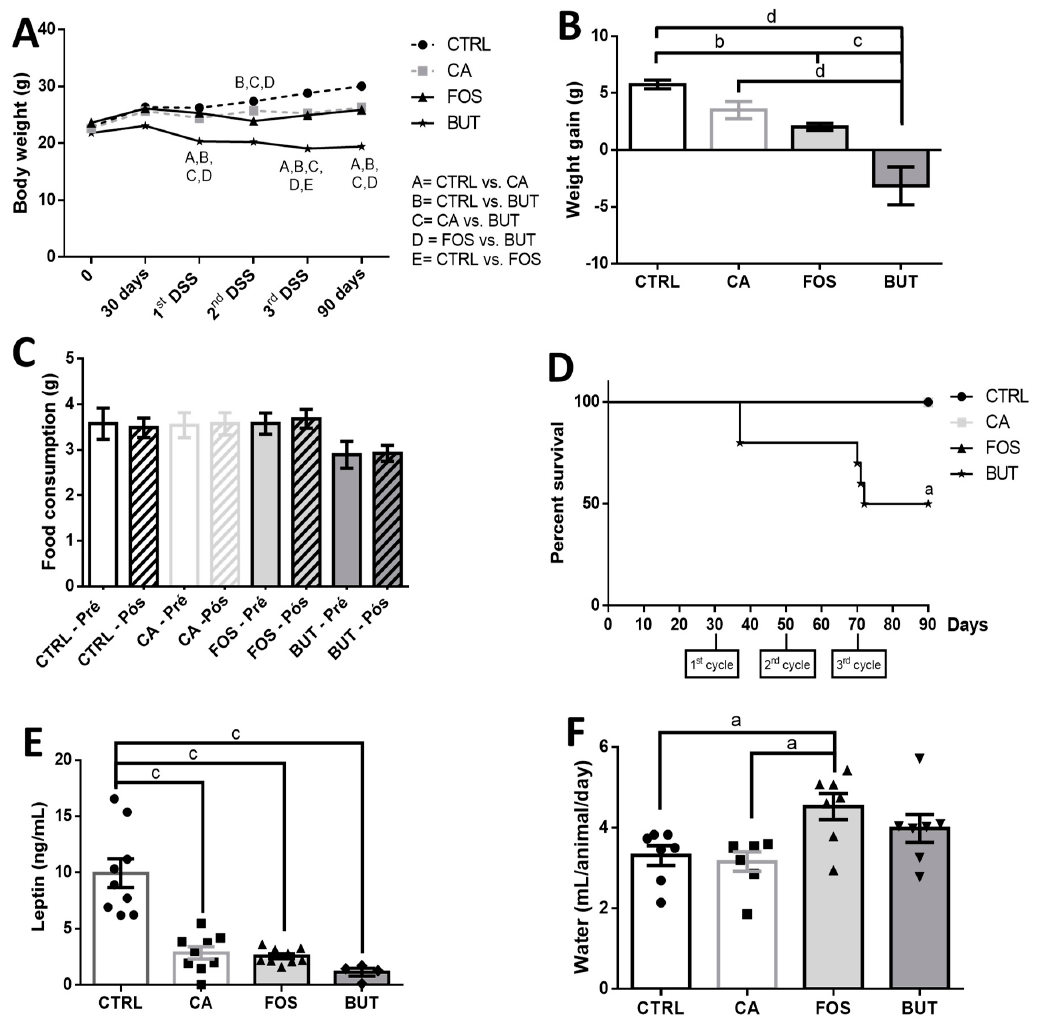
Figure 2. Butyrate reduces body weight and leptin: evolution of body weight ( A ), weight gain ( B ), food consumption ( C ), percent survival ( D ), serum leptin ( E ), and water intake ( F ). Mice were divided into four groups: control group (CTRL— n = 9–10) fed with chow diet; and colon carcinogenesis-induced groups fed either with chow diet (CA— n = 9–10), tributyrin-supplemented diet (BUT— n = 5–6), or with FOS-supplemented diet (FOS— n = 9–10). Colon carcinogenesis was induced chemically by azoxymethane (AOM)/dextran sodium sulphate (DSS). Data are presented as means ± SEM. The groups were compared using one-way ANOVA followed by Bonferroni post hoc tests; for p < 0.05 (a), p < 0.01 (b), p < 0.001 (c), and p < 0.0001 (d); black circles ( ● ), square ( ∎ ), triangles ( ▲ ) , inverted triangles ( ▼ ) represents sample numbers in the corresponding group.